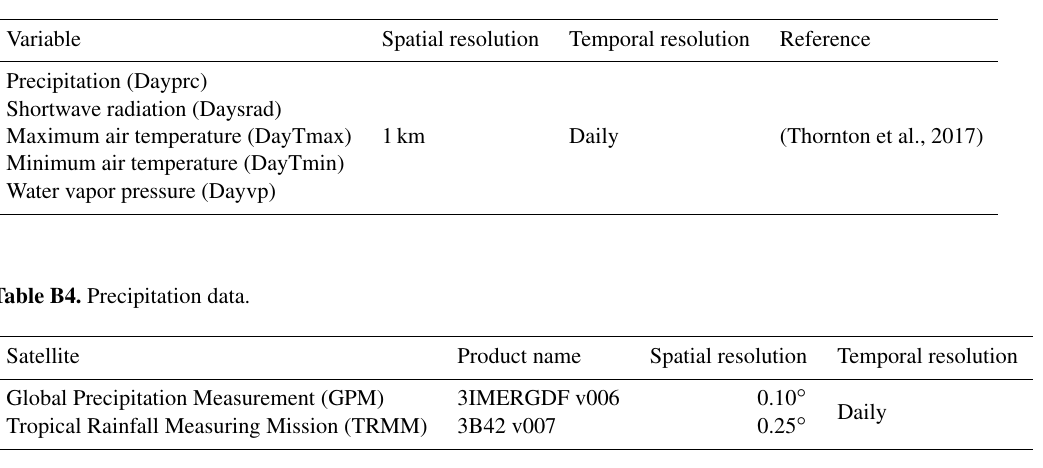
Table B3. Daymet meteorological database.